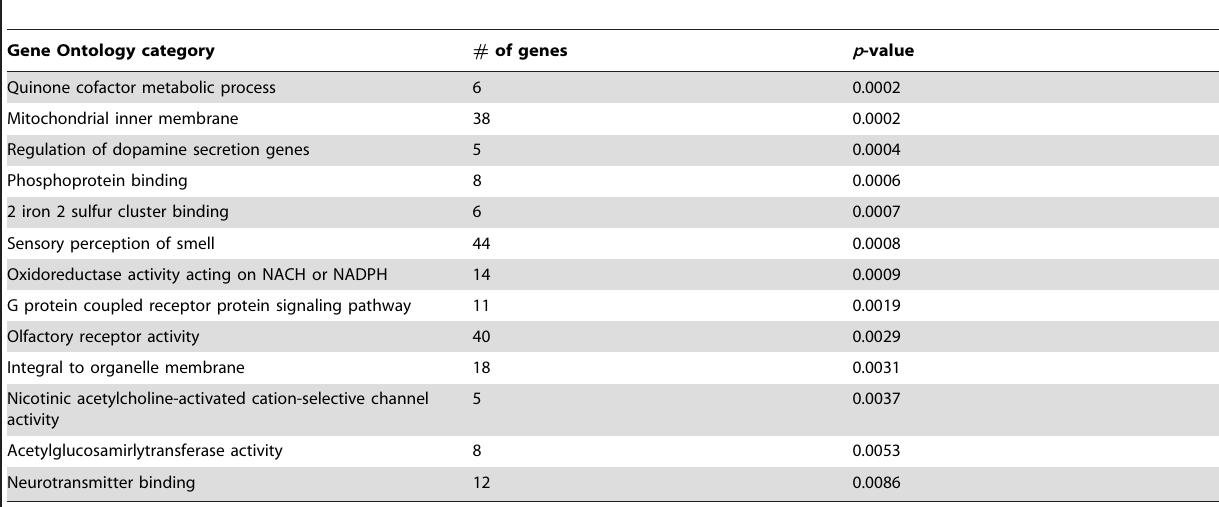
Table 4. Functional categories in Gene Ontology that were significantly enriched in the genes associated with weight gain.